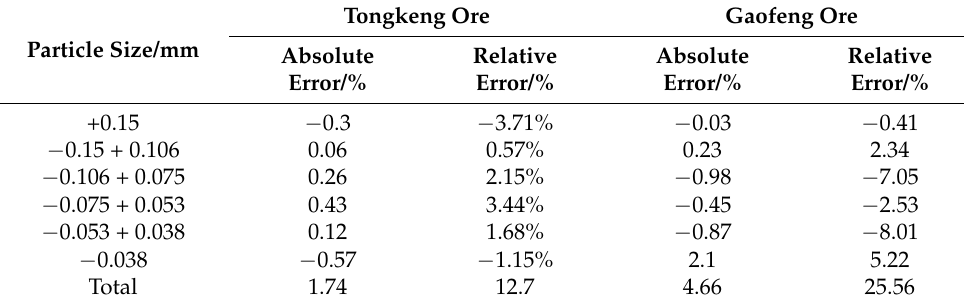
Table 9. Error comparison of Tongkeng ore and Gaofeng